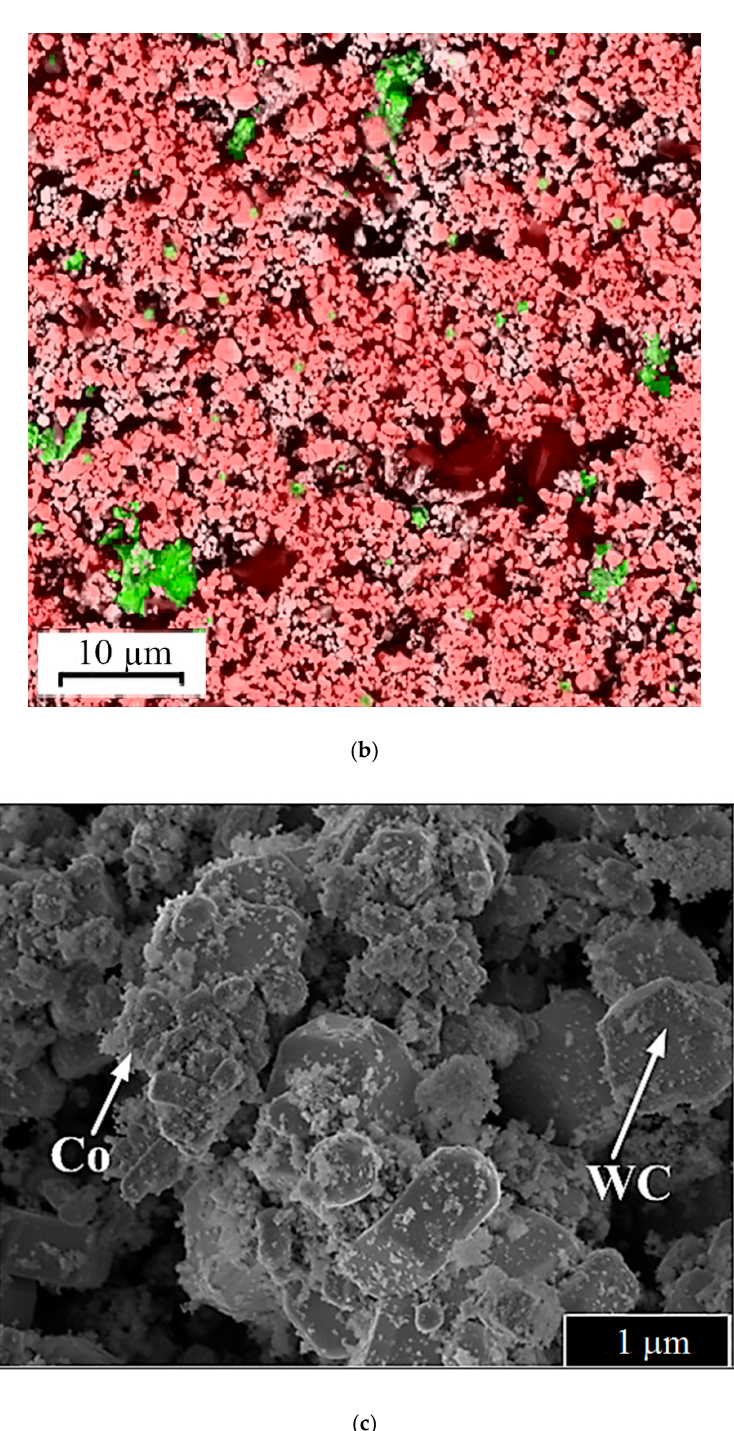
Figure 3. Photos of ( a ) the distribution of chemical elements in a mixture of 94 wt% micron powder tungsten carbide (WC) (red—tungsten) and 6 wt% nanopowder cobalt (Co) (green—cobalt) before processing in ball milling and ( b ) after processing in a ball mill. ( c ) SEM image of the mixture after processing in a ball mill.